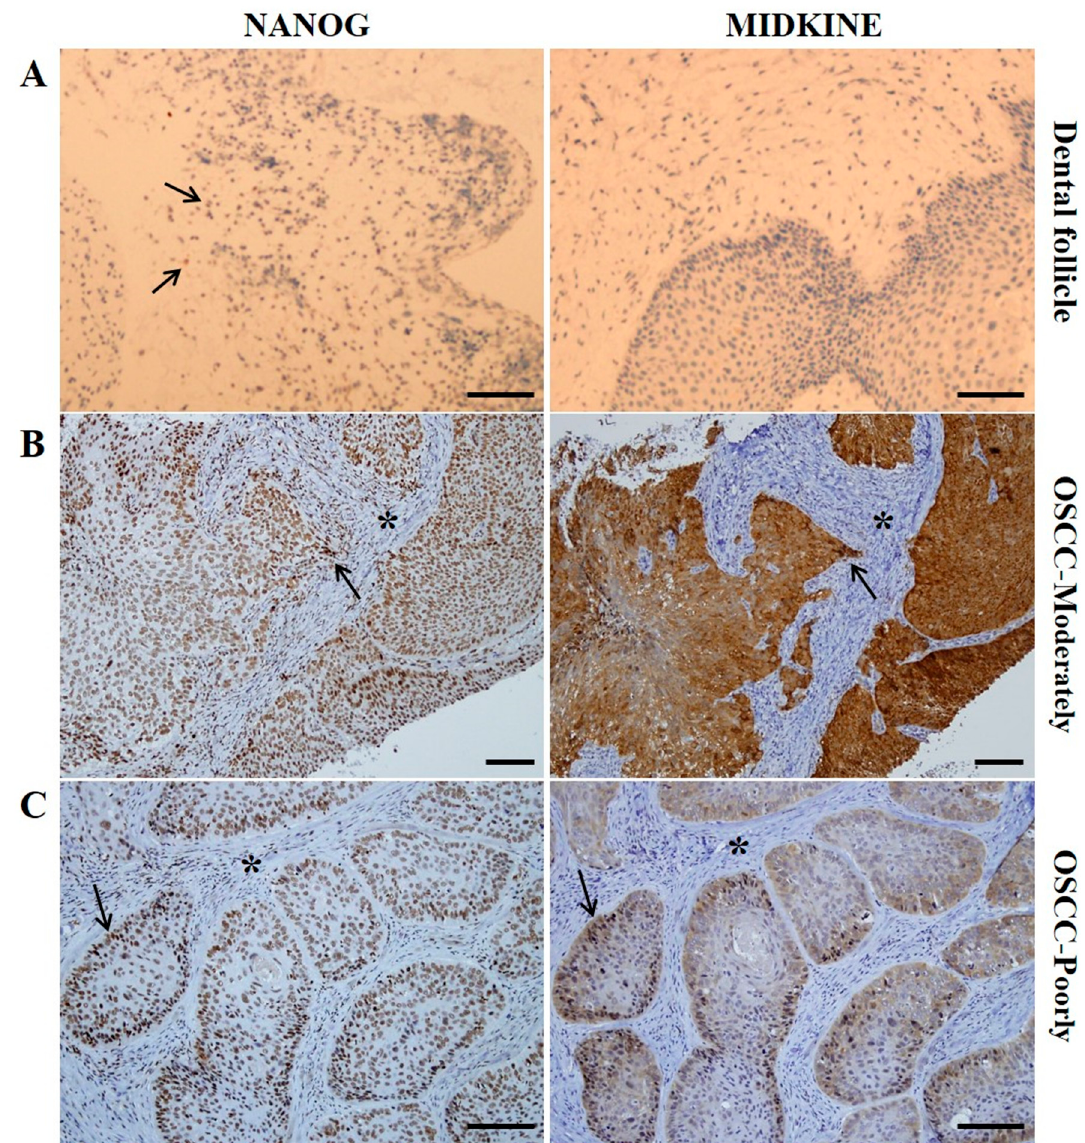
Figure 1. Results of IHC staining of MIDKINE (MK) and NANOG in control and OSCC specimens. ( A ) In dental follicle tissue from extracted wisdom tooth (control), MK is negatively expressed, whereas some cells show weak expression of NANOG proteins ( arrows ), which might be related to undifferentiated mesenchymal stem cells in dental follicle tissue; ( B , C ) in serial sections of high-grade (moderately- and poorly-differentiated) OSCC specimens, MK and NANOG proteins showed highly similar expression patterns, were negatively expressed in interstitial tissue ( * ) and strongly expressed in cancer cells. NANOG is predominantly expressed in the nuclei of cancer cells but is usually detected in the cytoplasm, indicating high stemness of these cancer cells. MK is mainly expressed in the cytoplasm of cells but it is also highly detected in nuclei, which might be related to the higher proliferation rate and increased survivability of cancer cells. Interestingly, a large proportion of OSCC cells in high-grade tumors showed strong co-detection of MK and NANOG (arrows). Scale bar = 50 µm.